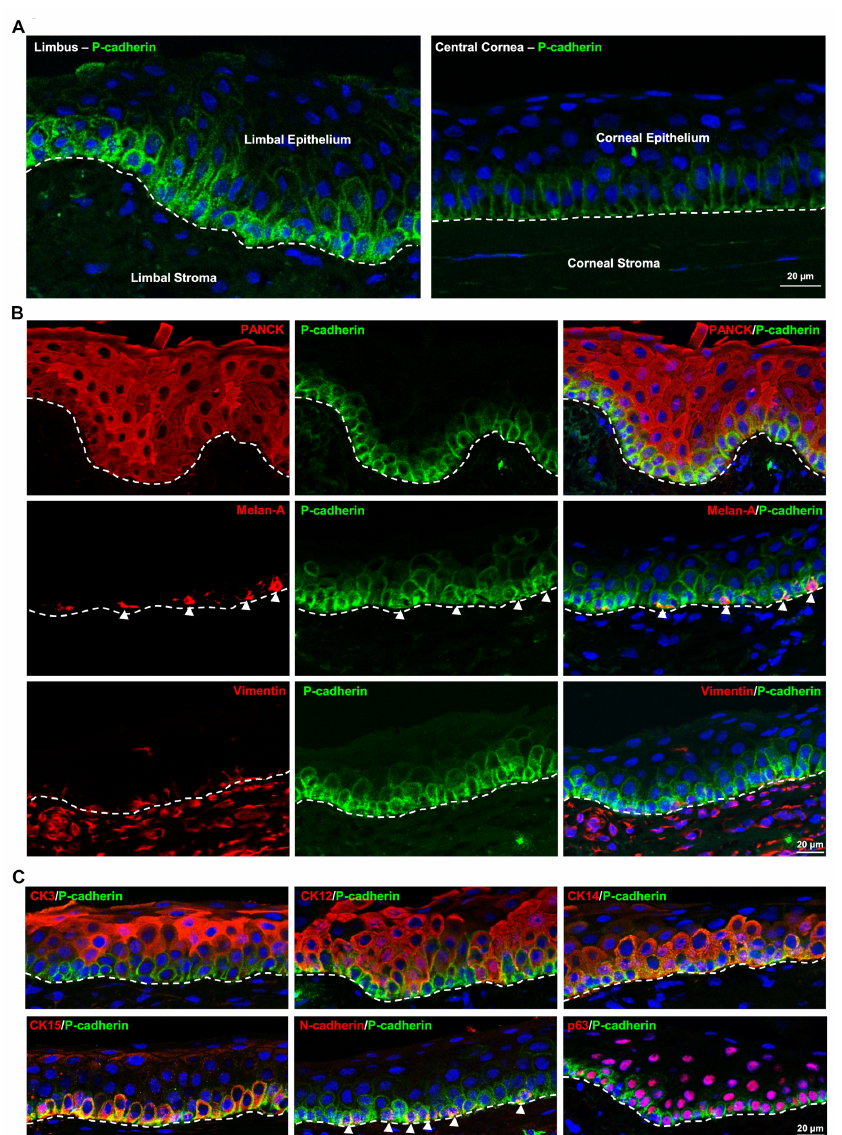
Figure 1. Localization of P-cadherin (P-cad) at the corneal limbus: ( A ) Immunohistochemical staining of fresh corneoscleral tissues showing the expression of P-cad (green) in the basal layers of limbal epithelium and a rather weak expression in the corneal basal epithelium (dashed line represents basement membrane (BM)). Nuclear counterstaining with 4 (cid:48) ,6-diamidino-2-phenylindole (DAPI, blue). ( B ) Double immunostaining analysis of limbal tissue sections showing the colocalization of epithelial keratins (pan-cytokeratin (CK), red) and P-cad (green) in the basal limbal epithelium); colocalization of melan-A (red) and P-cad (green) in the melanocytes (arrowheads); whereas sub- epithelial stromal cells (vimentin + , red) were in close association with P-cad + limbal basal epithelial cells (green, dashed line represents BM). Nuclear counterstaining with DAPI (blue). ( C ) Double immunostaining of limbal tissue sections showing non-colocalization of P-cad + cells (green) with epithelial differentiation markers CK3 and CK12 (red), whereas colocalization with progenitor/stem cell markers CK14, CK15, N-cadherin (arrowheads), and p63 (red, dashed line represents BM) ( C ). Nuclear counterstaining with DAPI